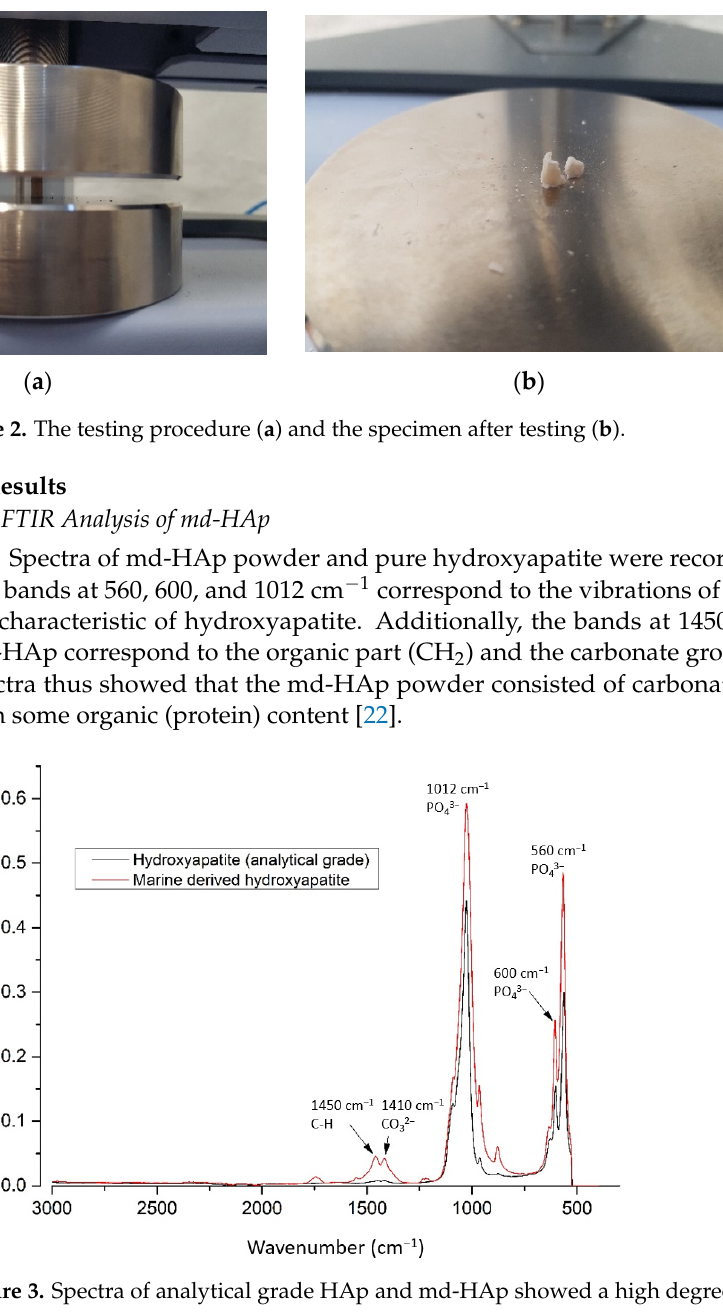
Figure 4. Compression stress–strain diagram. The mean values for the four groups of materials ( N = 6) are shown in the diagram. The control group in which Fuji IX was not modified exhibited the highest compressive stress and compressive strength. Legend: FujiIX is a control group, Fu- jiIX3TiO 2 is material with 3% of TiO 2 , FujiIX3HAP is material with 3% HAp and FujiIX1.5TH mate- rial with 1.5% of TiO 2 and 1.5% of HAp.